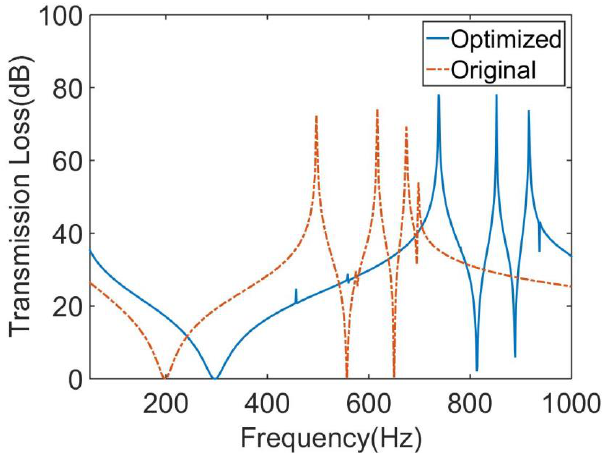
Figure 16. Schematic of the optimization process.